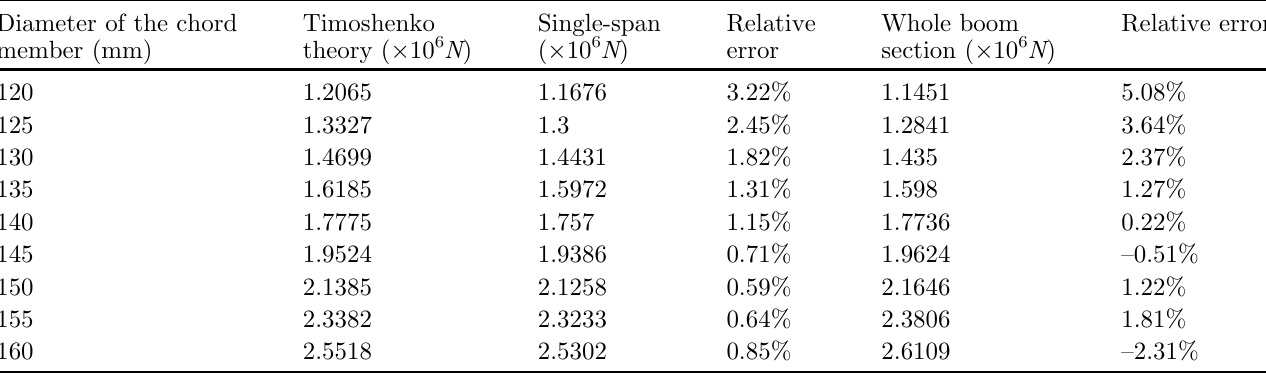
Fig. 8. Critical force variation trend with the inclination angle change. Table 5. Comparison under different chord member sizes.